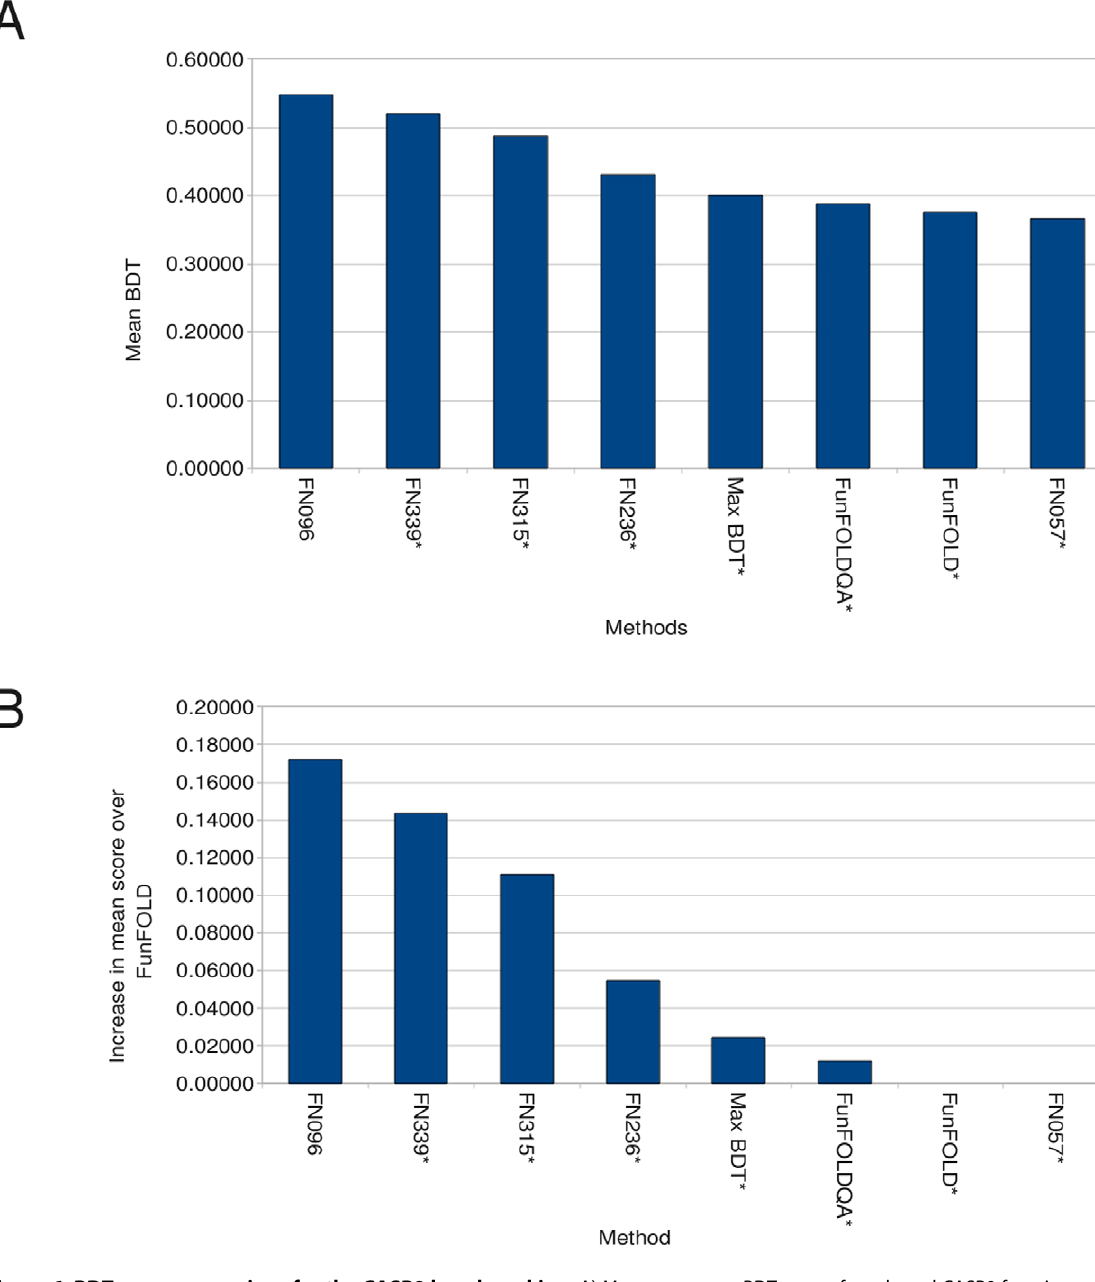
Figure 6. BDT score comparison for the CASP9 benchmarking. A) Mean per-target BDT scores for selected CASP9 function prediction groups along with FunFOLD, FunFOLDQA and the maximum score that could be obtained from FunFOLD. B) The added value, or increase in mean per-target score over FunFOLD (Minimum of 15 predications) * indicates server method.